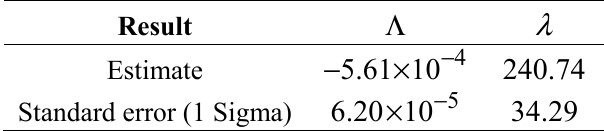
Table 3. Optimal model parameters and error bounds identified by the least squares